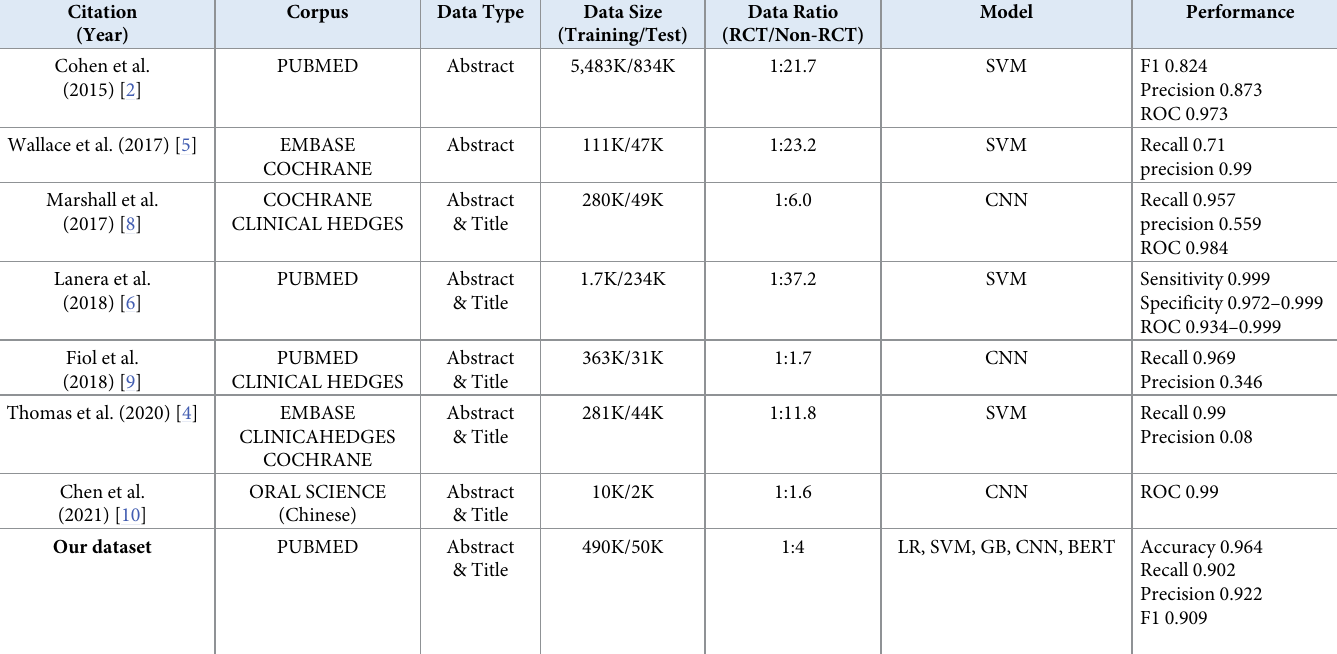
Table 1. Overview of prior work to identify RCTs in the biomedical literature and comparison of our dataset with existing ones. Despite the diversity of data sources, sizes, text types, and reported accuracies, the prior research heavily relies on SVM and CNN